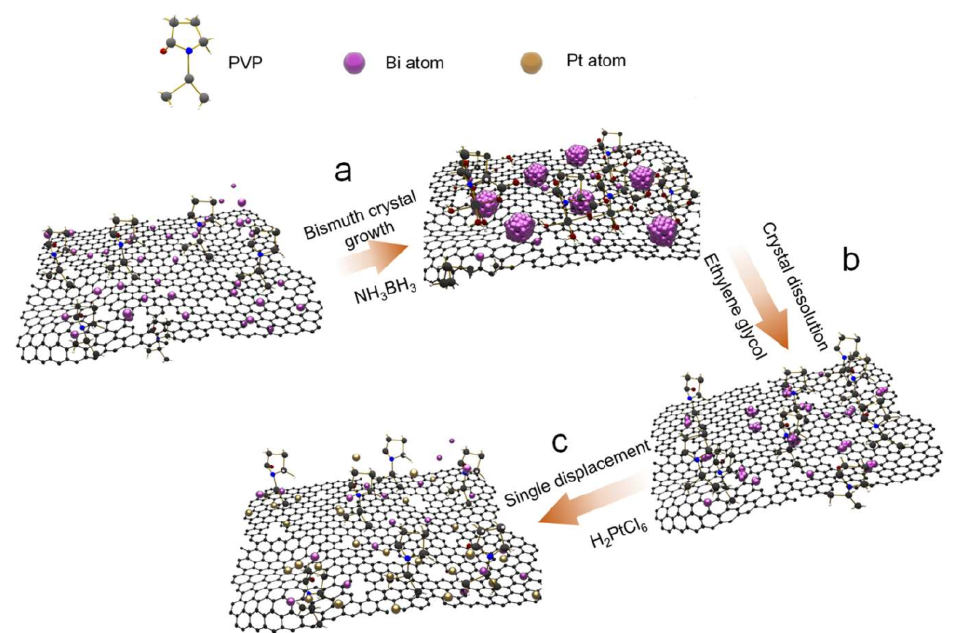
Figure 1. Illustrations of the facilitation and stabilization process show the displacement reaction route leading to the formation of ultra-small Pt/Bi/rGO. ( a ) Bismuth crystal grows on rGO surface, ( b ) Bi particles in solution are dissolved, ( c ) displacement reaction